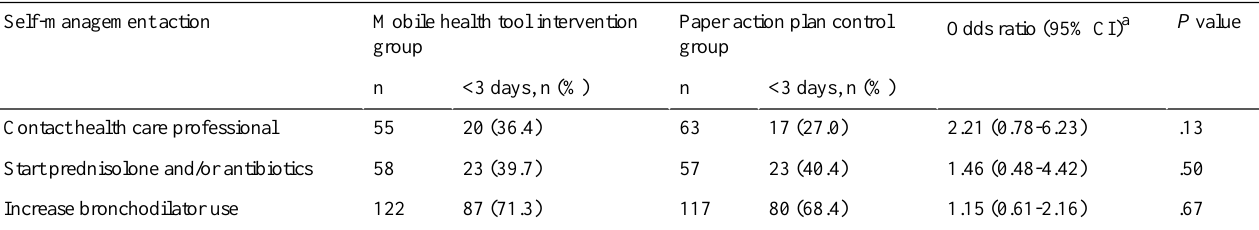
Table 4. Self-reported self-management behavior within 3 days of exacerbation onset.